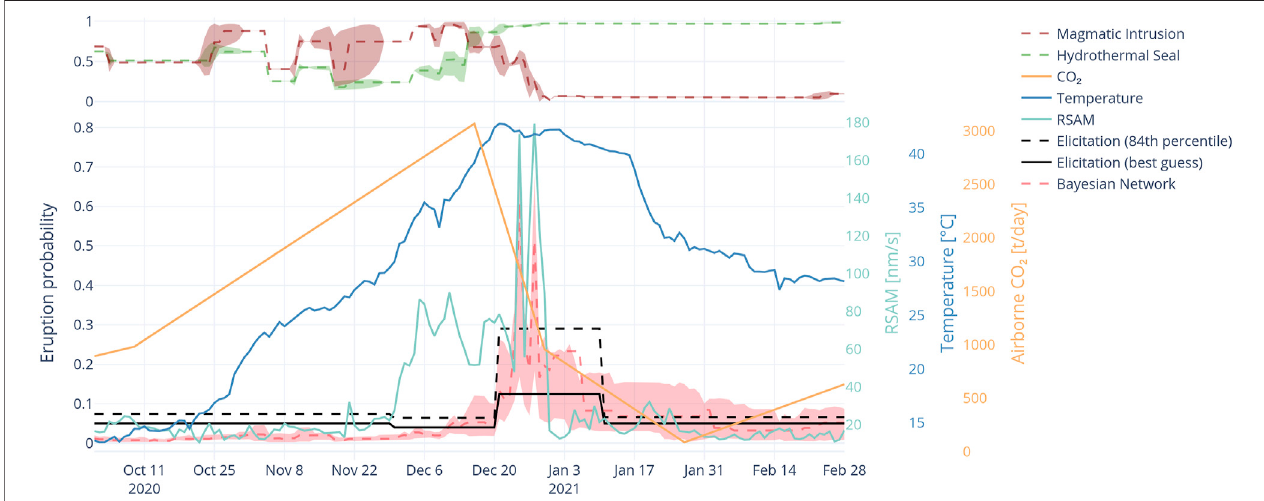
FIGURE 11 | BN forecast timeseries from October 2020 to February 2021 covering period of high airborne CO 2 measurement and high lake temperatures. Pink shading indicates 90% con fi dence interval around the mean (red dashed line). Corresponding best guess and 84th percentile values from expert elicitation shown in black curves. Lake temperature, RSAM and CO 2 fl ux are shown by blue, green and orange curves respectively. The top panel indicates the values of the magmatic intrusion (red dashed line) and hydrothermal seal (green dashed line) with shading the 90% con fi dence interval.